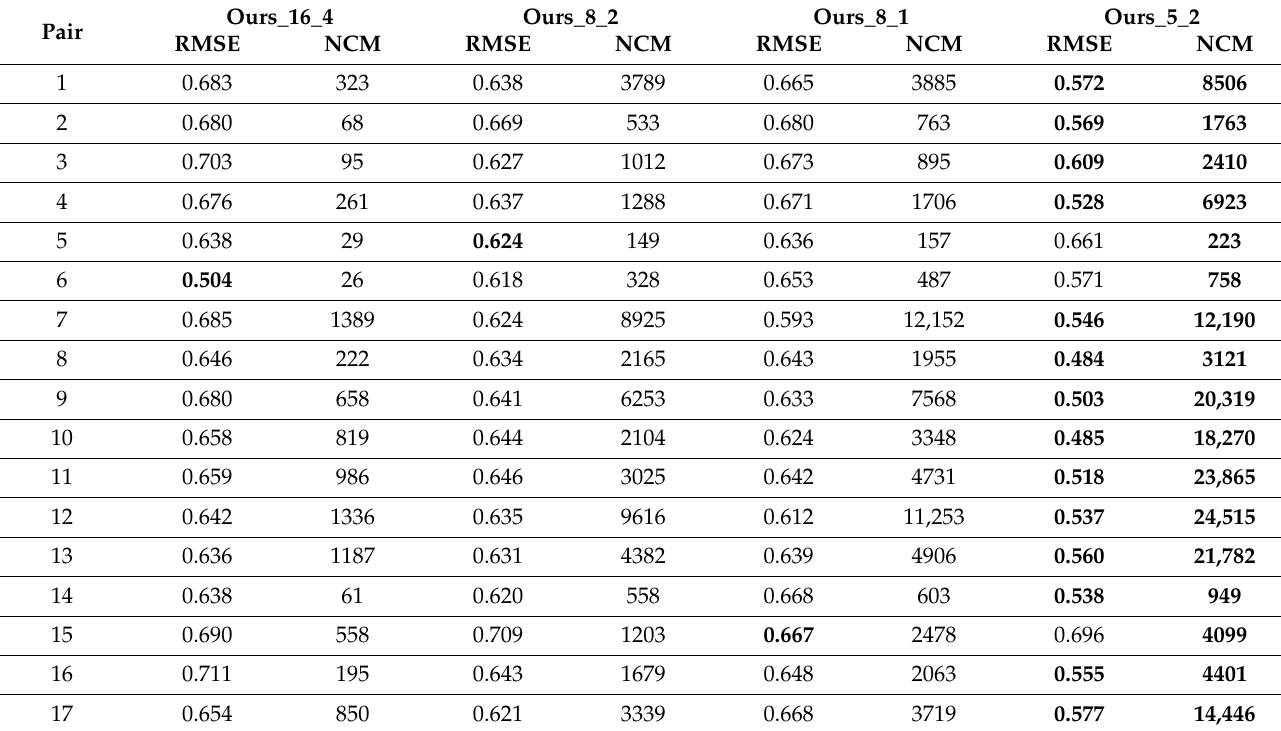
Table 3. RMSE and NCM of the different resolution settings on the